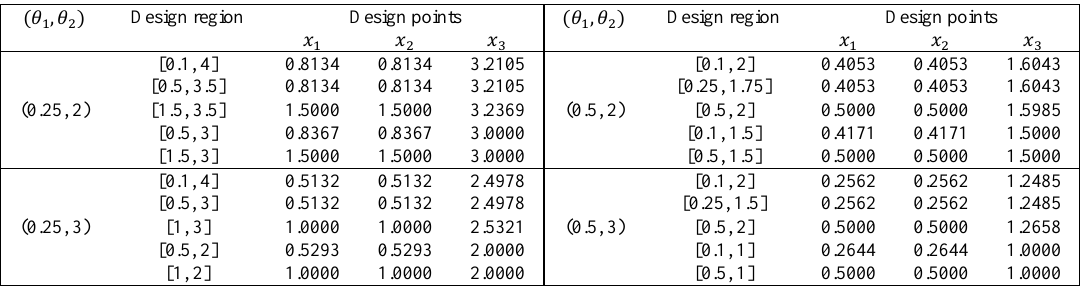
Table 9. E-optimal designs for generalized Pareto model with three support points having weights